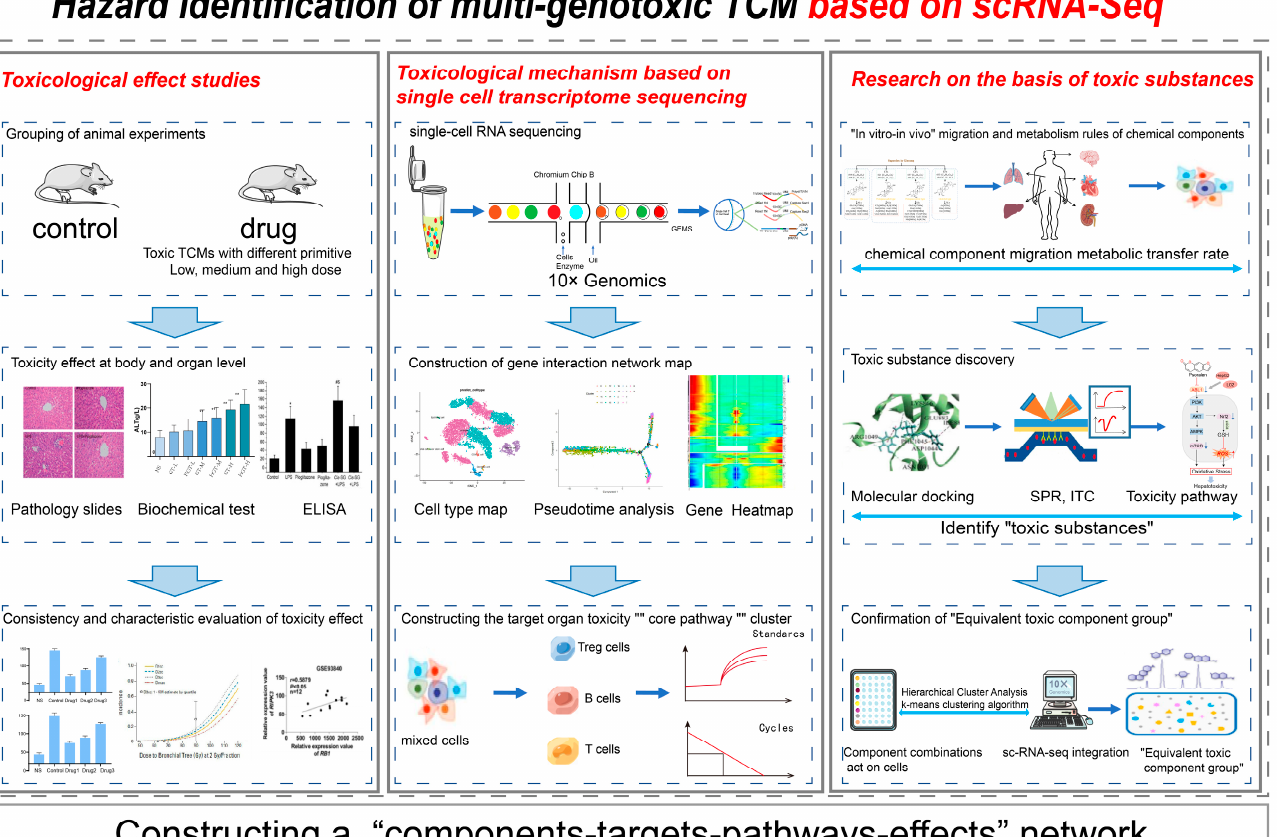
Figure 4. Research ideas and methods of hazard identification of multi-genotoxic TCM based on scRNA-Seq.